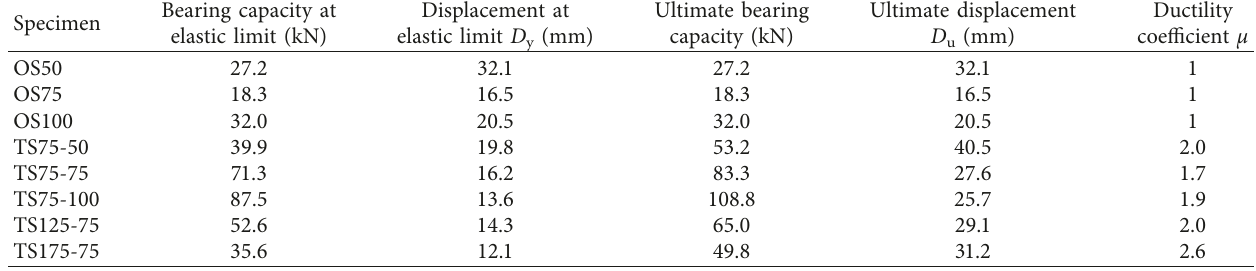
Table 2: Experimental results of the ultimate load capacity, displacement, and ductility coefficient. Bearing capacity at Specimen